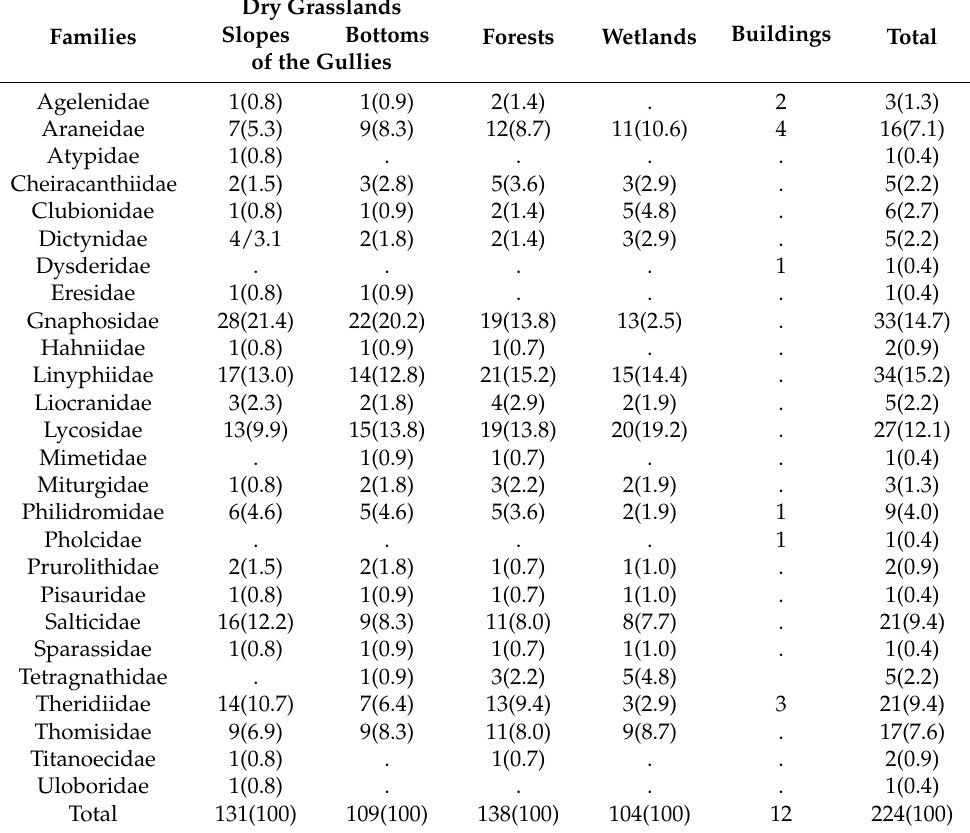
Table 2. Species richness of the spider families in the main types of habitats of the study site. Number of species (% in the fauna).